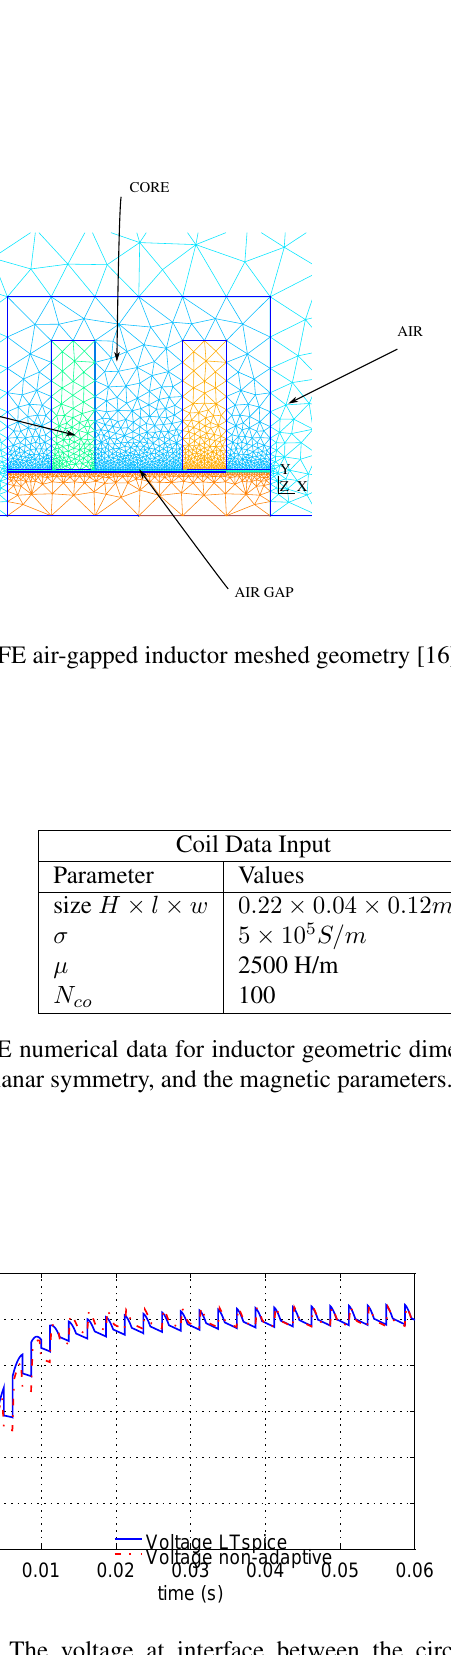
Figure 5: The voltage at interface between the circuit and the field case of large load resistance, a boosted volt- age from input constant voltage of 100V to 200V. A co- simulation window of 24 times the switching period of the transistor is considered.